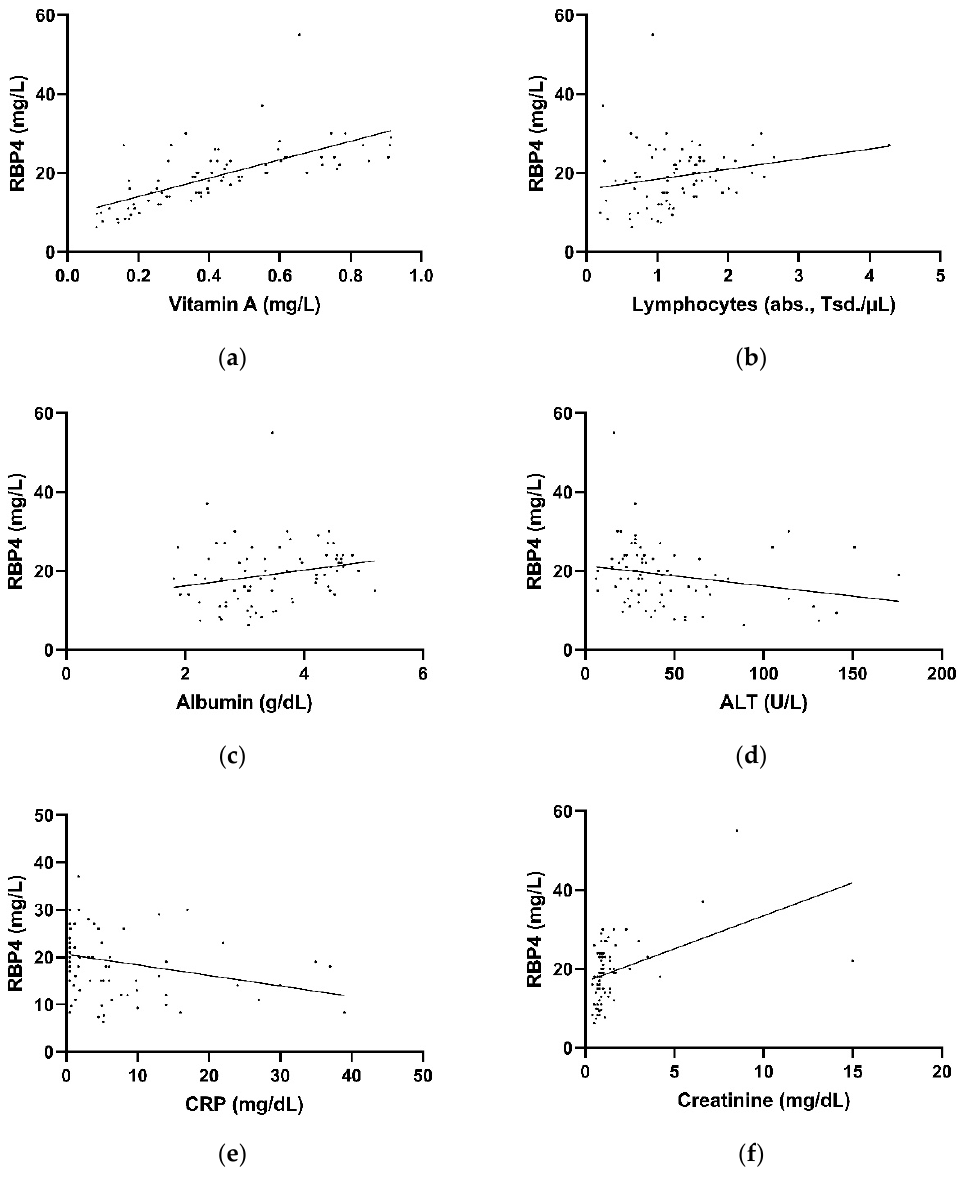
Figure 3. Correlation of retinol-binding protein plasma levels with vitamin A ( a ), lymphocytes ( b ), albumin ( c ), ALT ( d ), CRP ( e ), and creatinine ( f ). ALT, alanine transaminase; CRP, C-reactive protein.